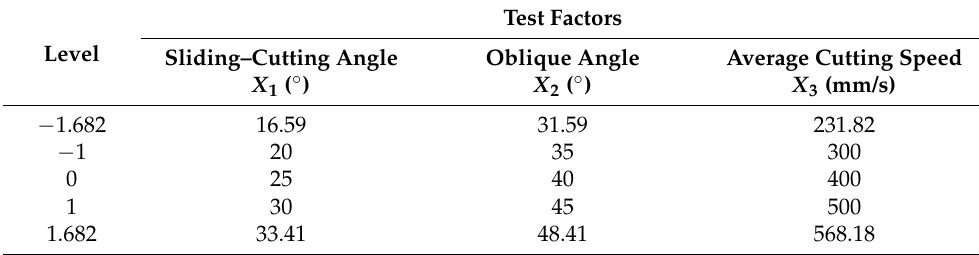
Table 3. Levels and codes of experimental variables.